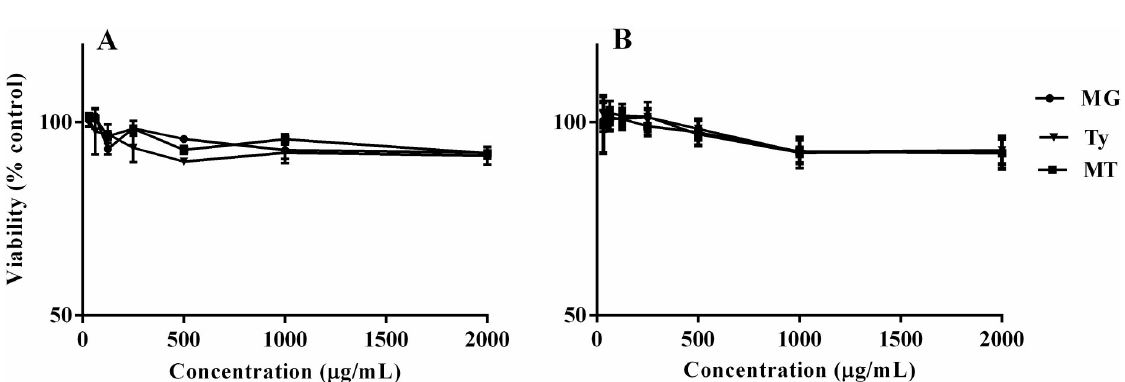
Fig 6. The viability of RAW 264.7 macrophages (A) and Caco-2 epithelial cells (B) exposed to different concentrations of methyl gallate (MG), tylosin (Ty) and their combination (MT). Percentage viability was calculated relative to the non-treated control cells. The initial 2000 μ g/mL MT concentration represents a combination of 2000 μ g/mL MG and 2000 μ g/mL Ty. Values represent mean ± SEM of three independent experiments.